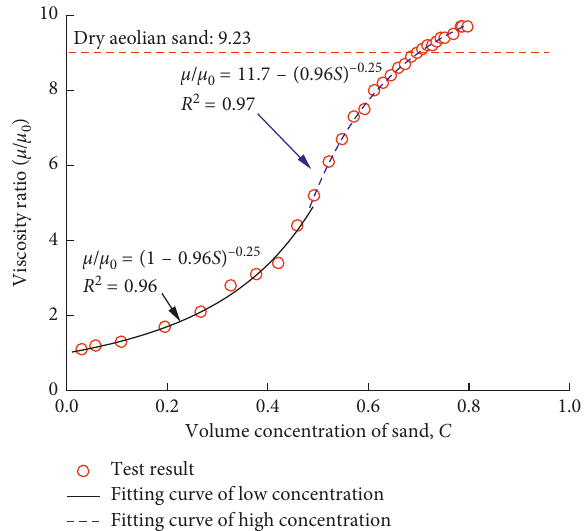
Figure 13: Dynamic viscosity ratio change curve with sand con- centration of sand-water mixture.